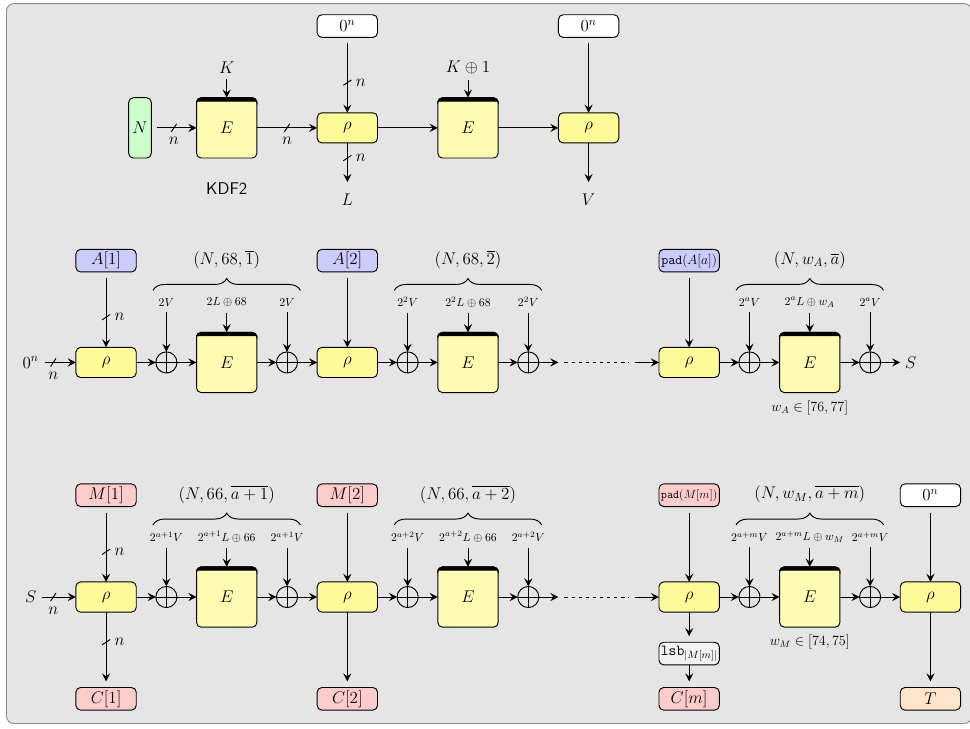
Figure 8: Remus-N with ICE2 ( Remus - N 2). (Top) Key derivation. (Middle) Processing of AD. (Bottom) Encryption. The domain separation B being of 8 bits only, ‘ B is to be interpreted as ‘ 0 120 } B